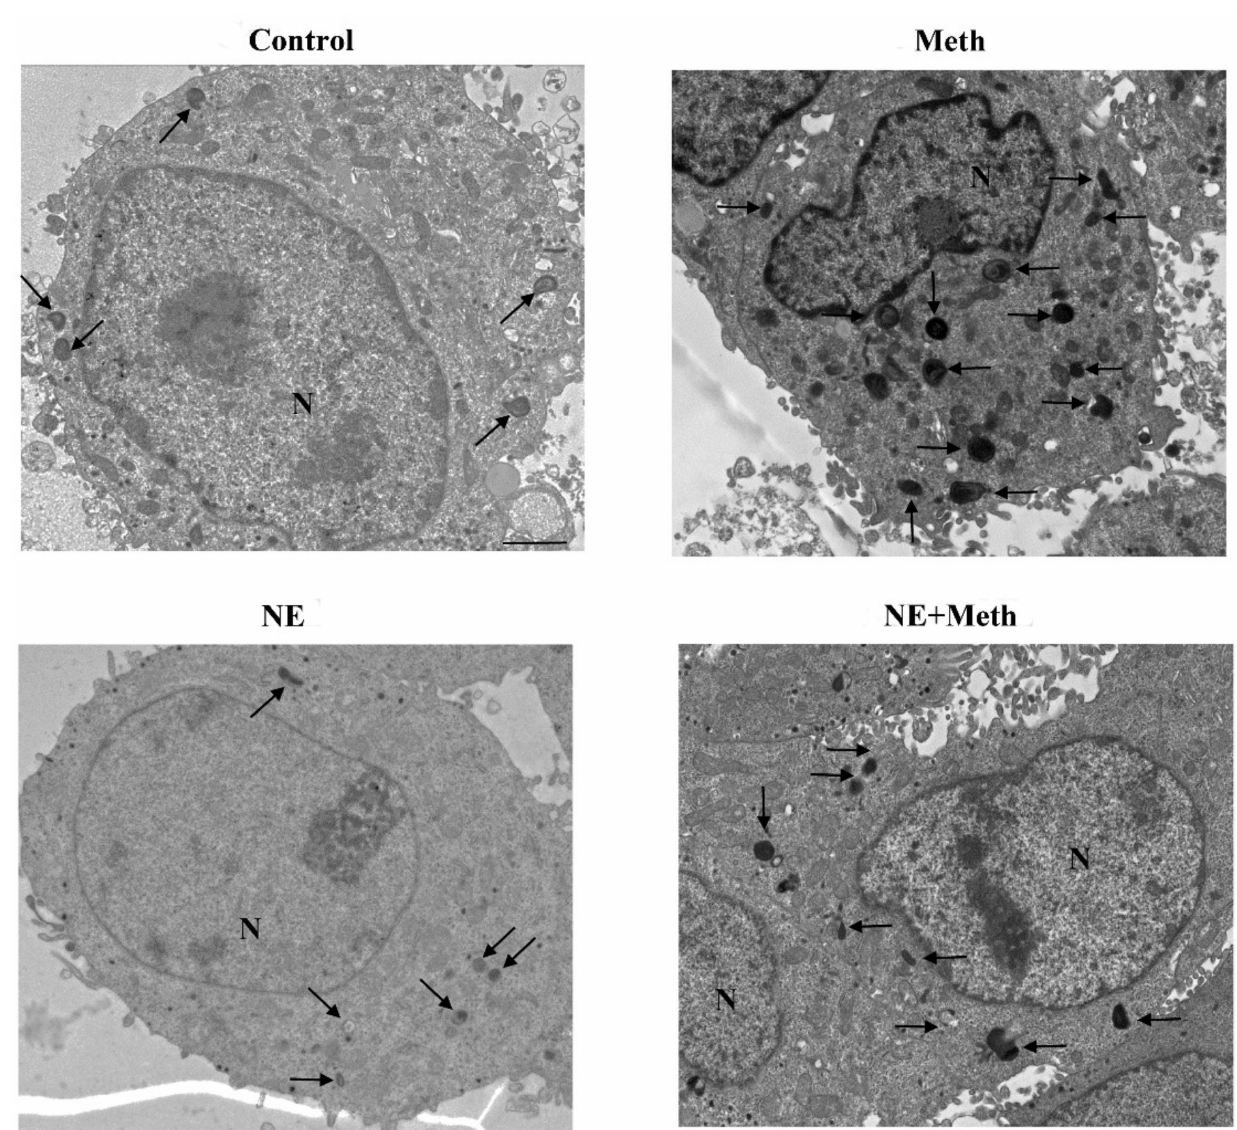
Figure 14. Representative TEM micrograph following NE and Meth of autophagy-like (low magnification). Representative TEM micrographs at low magnification of Control, Meth (50 µ M), NE (5 nM), or NE (5 nM) + Meth (50 µ M)-treated cells. Images show autophagy-like vacuoles. These correspond to vacuolar inclusions with double or multiple limiting membranes possessing the same electron density of cytosol sometimes interrupted by electron dense remnants. Autophagy-like vacuoles indicated by an arrow are increased in the cytosol by Meth, far exceeding the amount observed in Control or NE-treated cells. PC12 cells were fixed for TEM analysis 72 h after Meth administration. In the combined treatment, NE was administered 30 min before with Meth. Scale bar = 1 µ M. N =